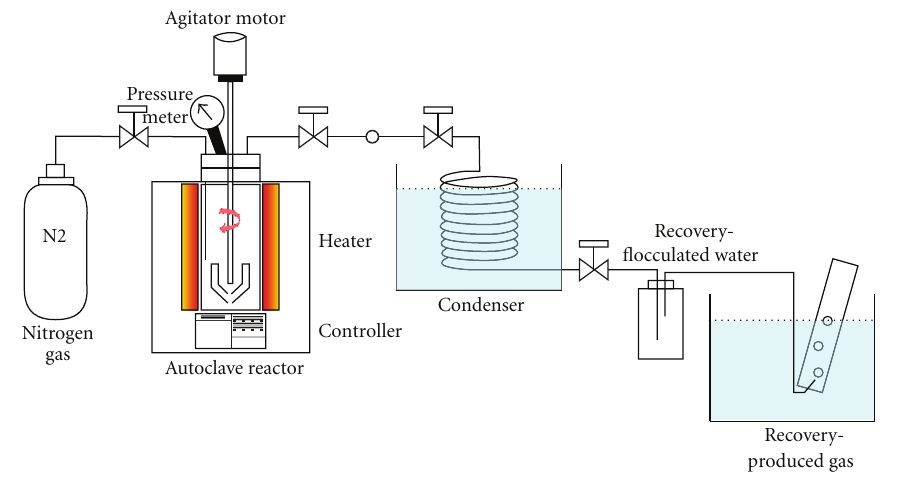
Figure 1: Schematic diagram of the autoclave facility.